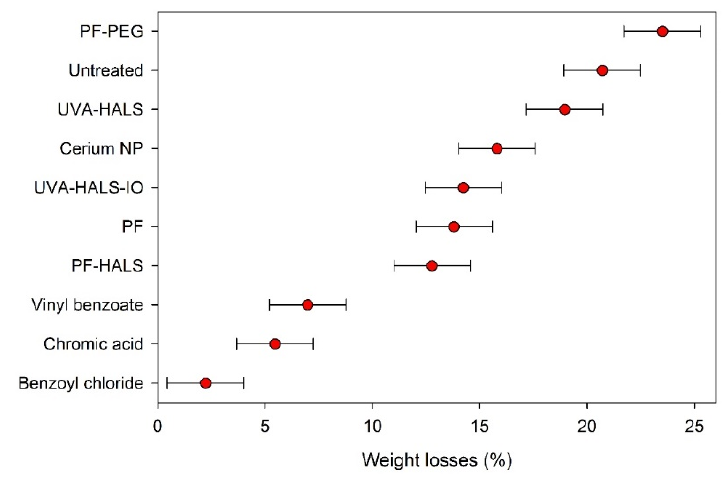
Figure 1. Weight losses of treated yellow cedar veneers exposed outdoors for 35 days.